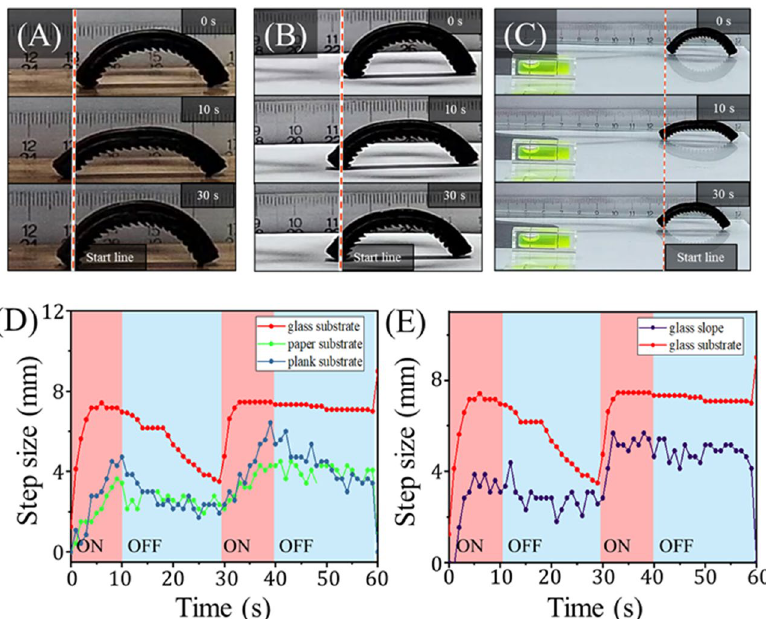
Figure 8. Analysis of mag-bots on rough terrain. ( A–C ) Snapshots of mag-bots with 30° pattern angles are shown at (top) 0 s (before actuation), (middle) 10 s (at the end of one extension cycle), and (bottom) 30 s (at the end of one complete cycle). The mag-bot is depicted walking on (A) a wooden plank, (B) printer paper, and (C) up a 5 ◦ inclined glass slope (see the level at the bottom left). (D) Net forefoot displacement is plotted with respect to time for the mag-bot walking on wood, paper, and the control condition of a level glass substrate. (E) Net forefoot displacement is plotted with respect to time for the mag-bot walking up the glass slope and the control condition (i.e., level